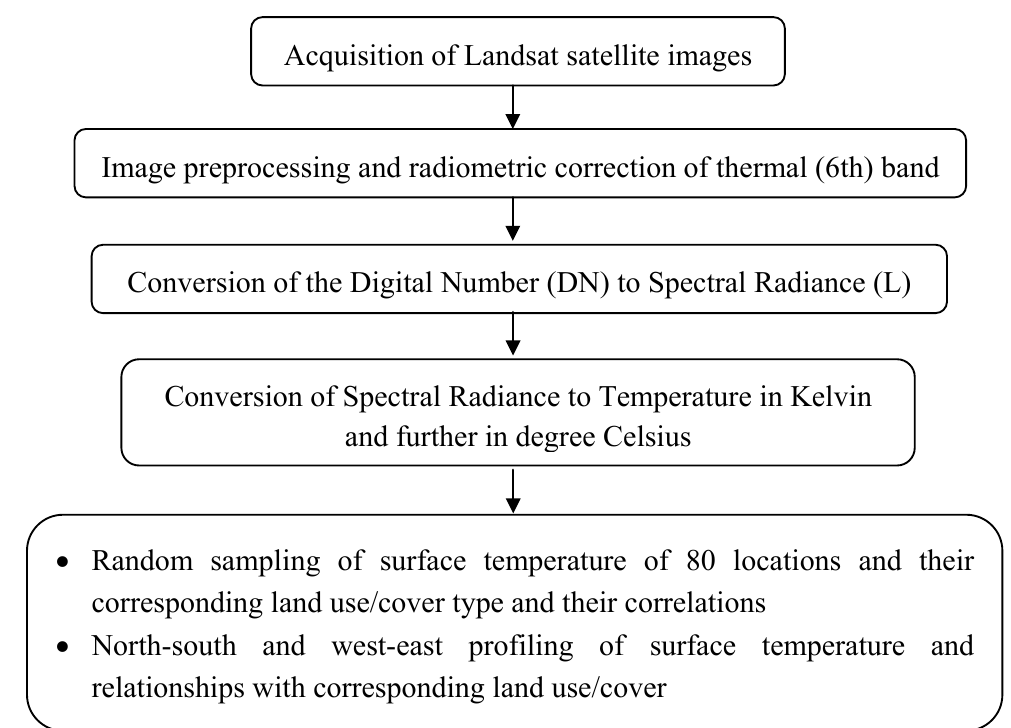
Figure 2. Methodological framework showing steps of processing of Landsat thermal satellite data and analysis of surface temperature